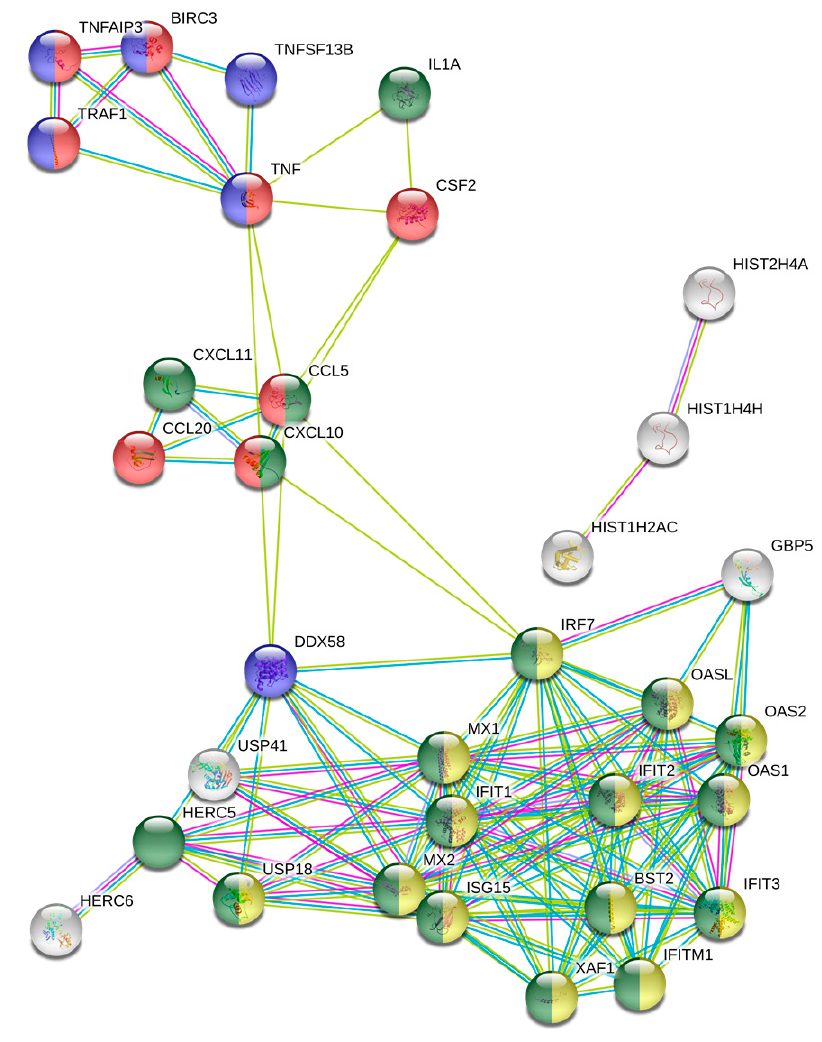
Figure 2. String network analysis of TBX2 induced differentially expressed genes. Table 1. KEGG pathway analysis of the differentially expressed genes.